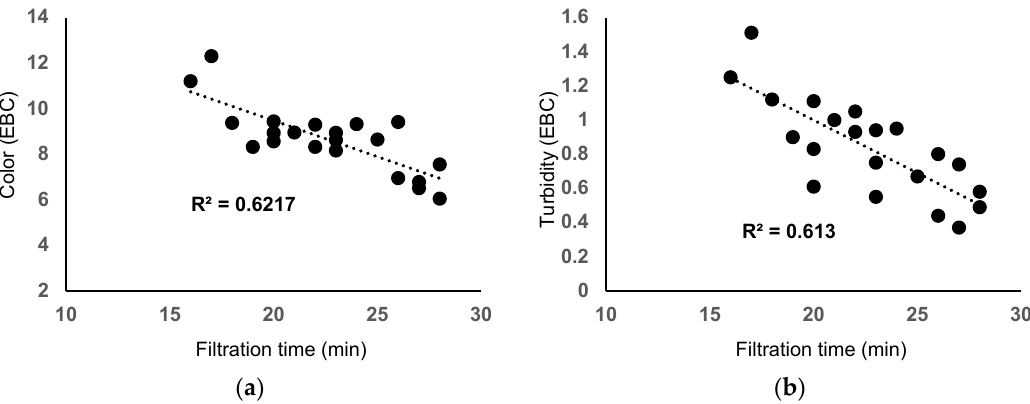
Figure 5. Correlation between filtration time and beer color ( a ) and beer turbidity ( b ).